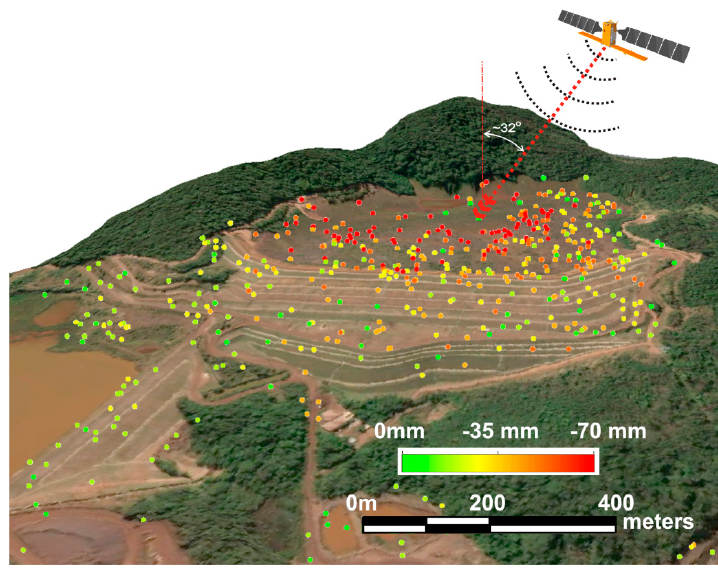
Figure 9. View in 3D of Dam-I showing the accumulated displacement from PSI analysis represented by colored dots.